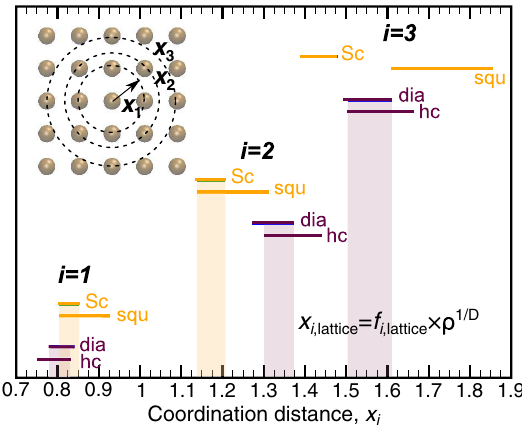
FIG. 3. Separations corresponding to first ( i ¼ 1 ), second ( i ¼ 2 ), and third ( i ¼ 3 ) coordination shells within the stability range of honeycomb (hc) ρ ¼ ½ 1 . 11 ; 1 . 37 (cid:2) and diamond (dia) ρ ¼ ½ 1 . 09 ; 1 . 38 (cid:2) ground states for φ hc , as well as square (squ) ρ ¼ ½ 1 . 16 ; 1 . 55 (cid:2) and simple cubic (Sc) ρ ¼ ½ 1 . 61 ; 1 . 95 (cid:2) ground states for φ . The coordination distance ( x ) for shell i is related to i squ f × ρ 1 = D , where D ¼ 2 for hc and density ( ρ ) by x i; lattice ¼ i; lattice squ, and D ¼ 3 for dia and Sc. For hc, f 1 ¼ 0 . 877383 ; ffiffiffi ffiffiffi p p 3 2 f 1 ; f 3 ¼ 2 f 1 ; for squ, f 1 ¼ 1 ; f 2 ¼ f 1 ; f 3 ¼ 2 f 1 ; f 2 ¼ ffiffiffiffiffiffiffiffi p ffiffiffiffiffiffiffiffiffiffi p 8 = 3 11 = 3 f 1 ; f 3 ¼ f 1 ; for Sc, for dia, f 1 ¼ 0 . 866025 ; f 2 ¼ ffiffiffi ffiffiffi p p 2 3 f 1 ¼ 1 ; f 2 ¼ f 1 ; f 3 ¼ f 1 . Shaded regions indicate overlap of coordination-shell distances for analogous 2D and 3D stable lattice ground